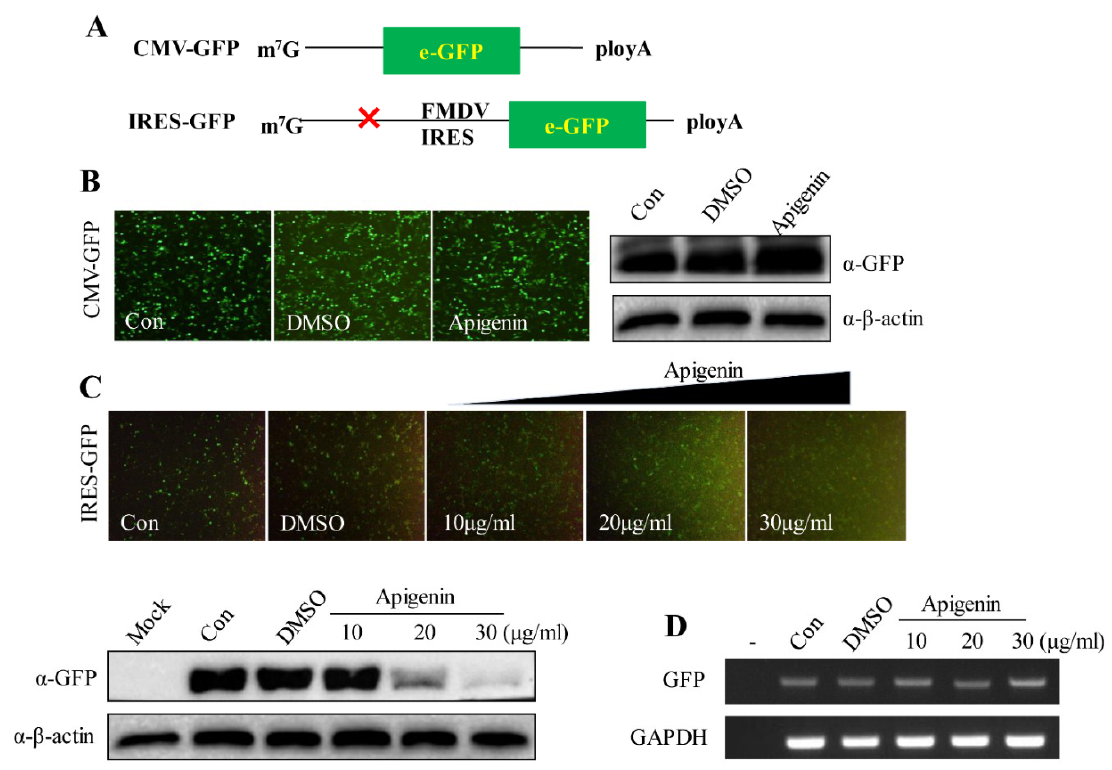
Figure 4. Apigenin exerts an inhibitory action on FMDV IRES activity. ( A ) Diagram of